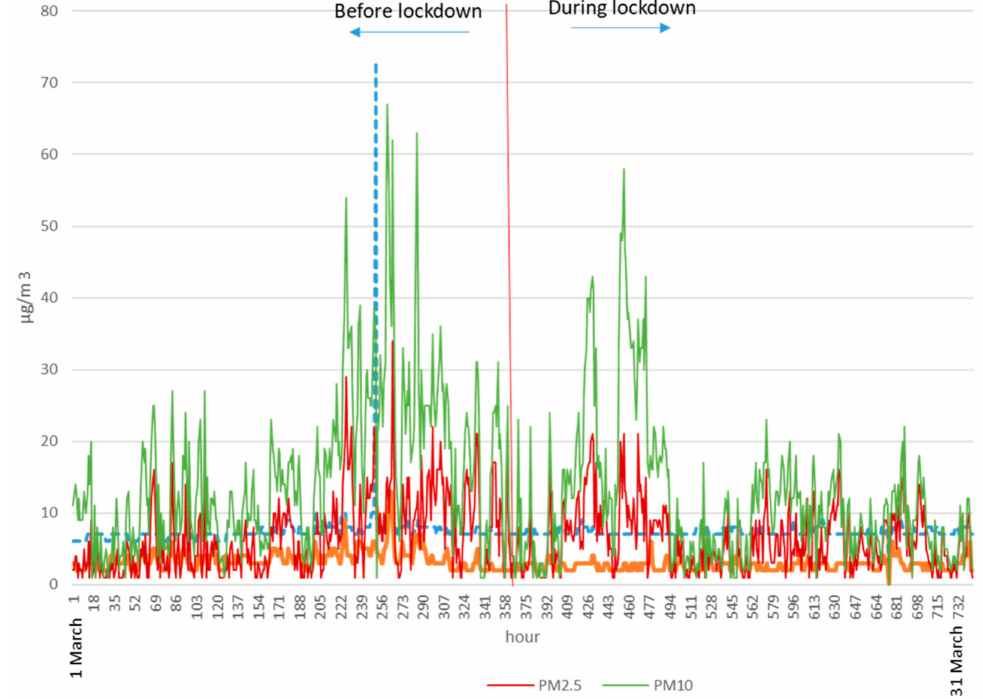
Figure 4. Concentrations of PM 2.5 and PM10 outside in Madrid before and during home confinement. (Source Sistema Integral de Calidad del Aire de Madrid).